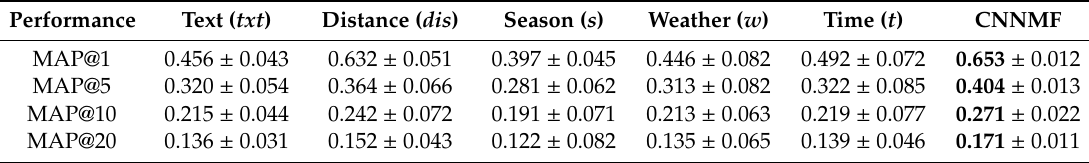
The performance of eliminating di ff erent types of information (results indicated as (mean ± standard